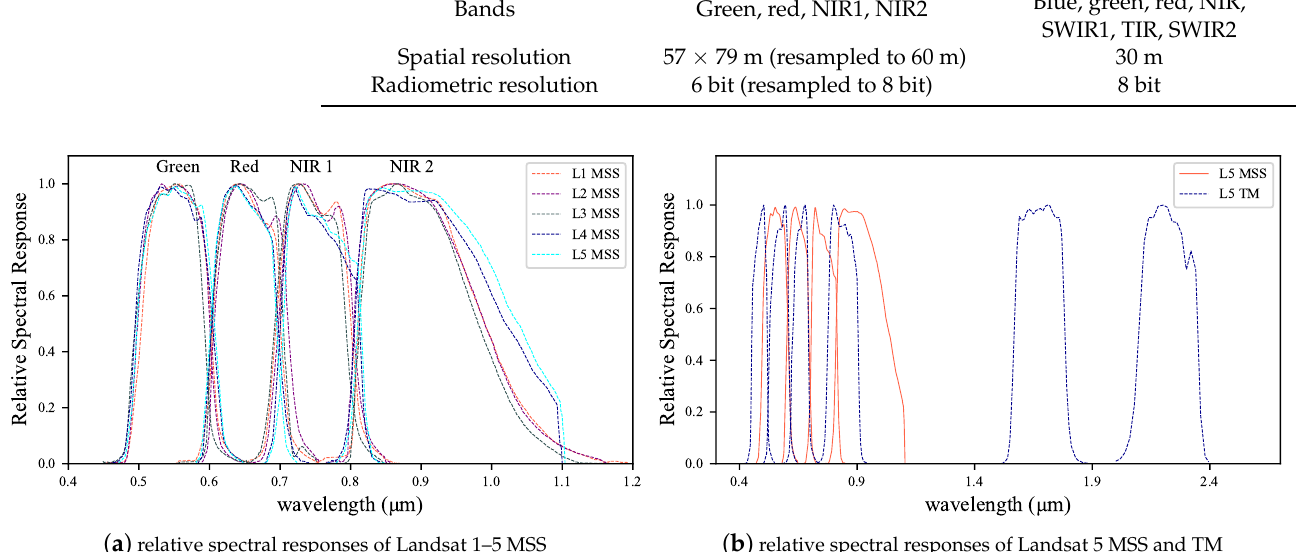
( b ) relative spectral responses of Landsat 5 MSS and TM Figure 1. Relative spectral responses of TM and